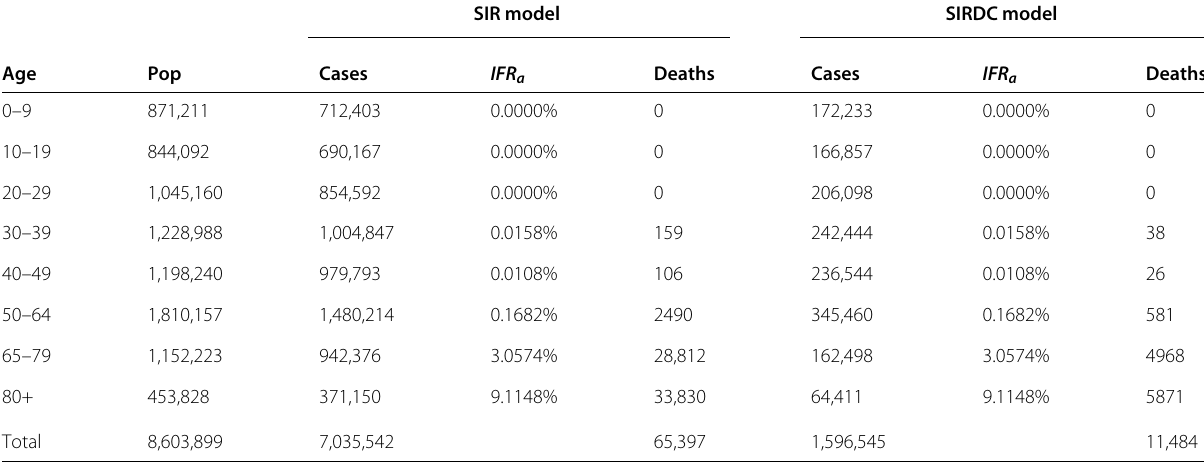
Table 6 Direct deaths (infections until September 1) SIR model SIRDC